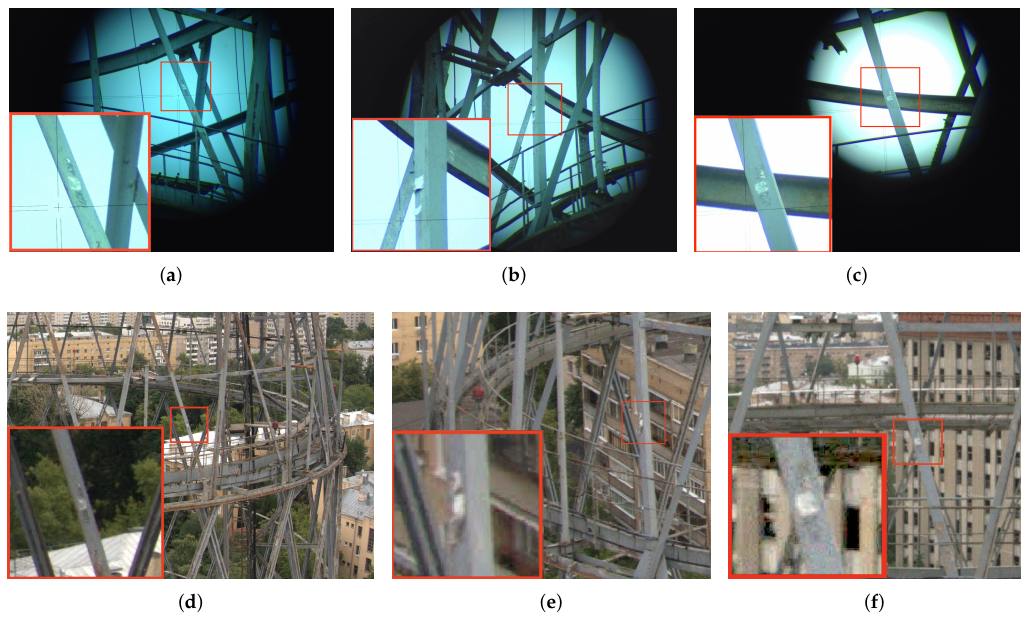
Figure 5. Special markers used for labeling the reference point measured by Geomax Zoom 25pro total station ( a – c ) and corresponding images from UAS imagery ( d – f ).